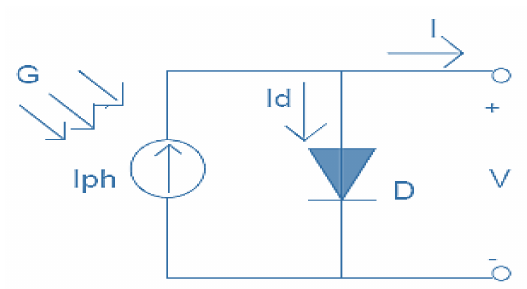
Figure 4. PV single cell